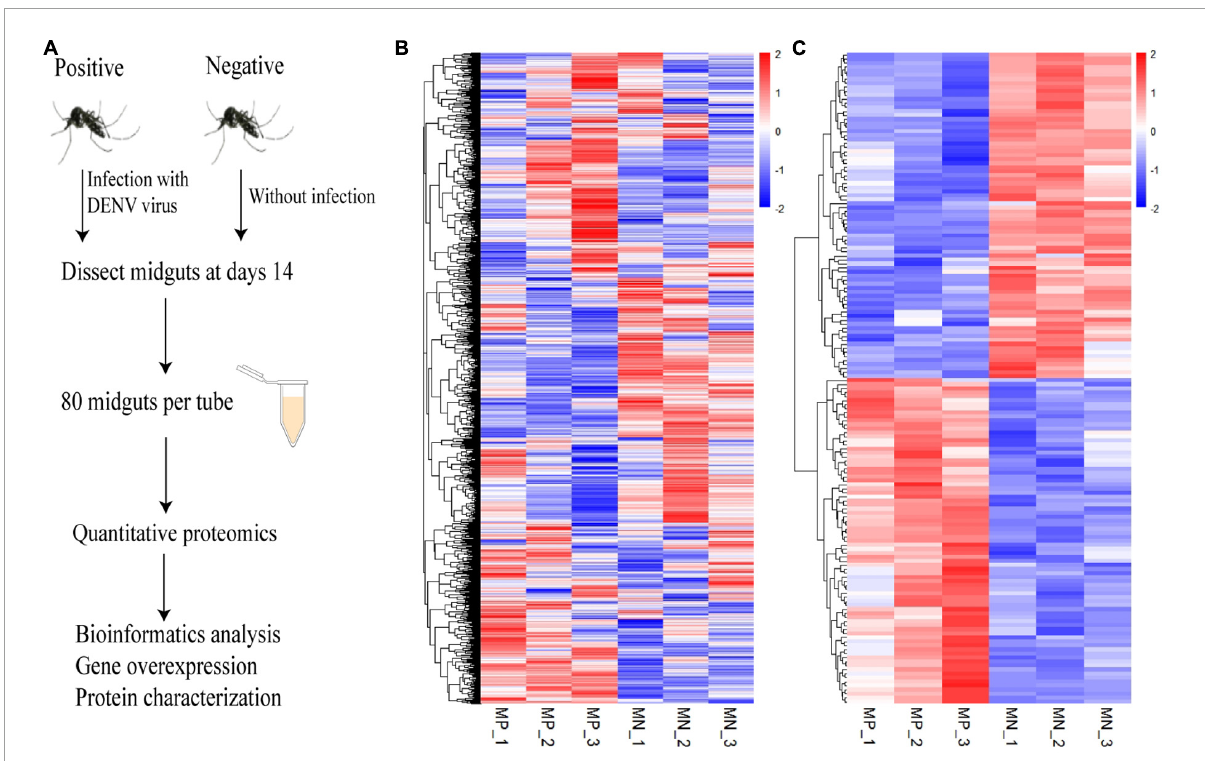
FIGURE1 Quantitative proteomics of the Ae. albopictus midgut during DENV infection. (A) Schematic diagram of the experimental procedure. Ae. albopictus mosquitoes were infected with DENV. Quantitative proteomics analysis was carried out at 14 days post infection. (B) The levels of 3,419 proteins between the infected and uninfected Ae. albopictus groups were determined by three repeated experiments. (C) Heat map of differential expressed proteins with a ratio of more than 1.2 times. Each column in the diagram represents a sample and each row represents a protein, and red represents a high levels and blue represents a low level. MP means mosquito-positive group, MN means mosquito-negative group.